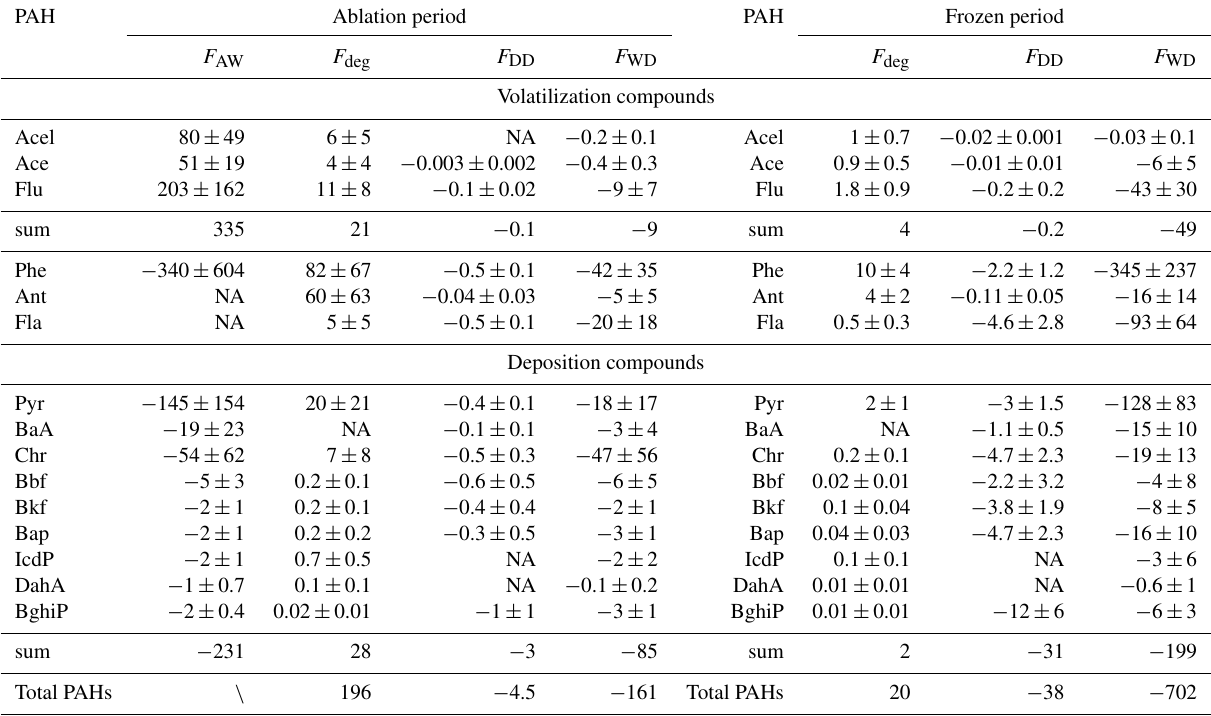
Table 1. Estimated fluxes (ngm − 2 d − 1 ) of air–water gas exchange ( F AW ), atmospheric degradation ( F deg ), dry deposition ( F DD ) , and wet deposition ( F WD ) for individual PAHs during the ablation period and frozen periods. PAH Ablation